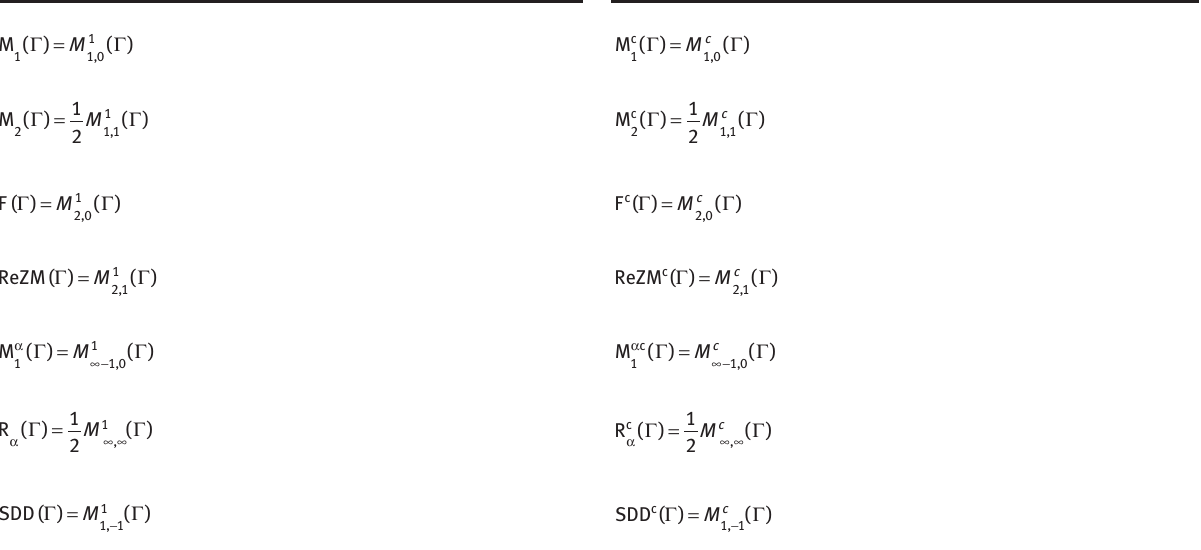
Table 2: Zagreb indices in terms of generalized Zagreb indices.